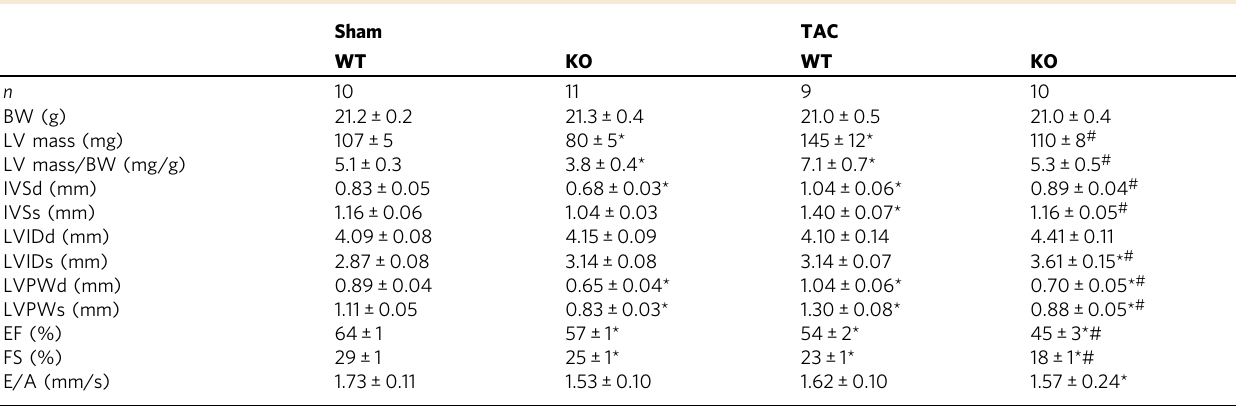
Table 1 Morphometric and echocardiographic characteristics of WT versus miR-106b~25 KO mice subjected to sham or TAC surgery for 4